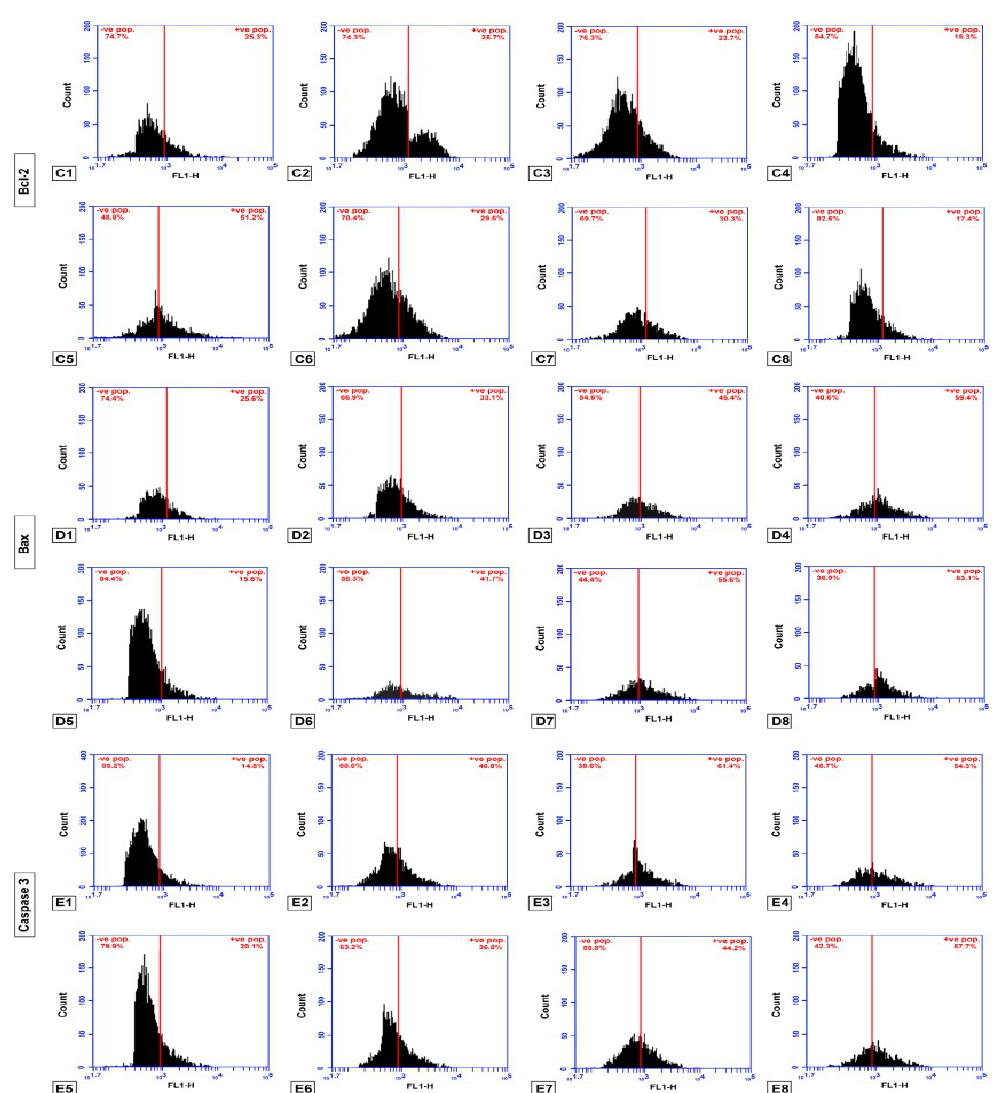
Figure 7. ( C ) Flow cytometry analysis of cell counts, detecting the number of Bcl-2 positive cells. ( D ) Flow cytometry analysis of cell counts, detecting the number of Bax positive cells. ( E ) Flow cytometry analysis of cell counts, detecting the number of Caspase 3 positive cells. 1: GMSCs control; 2: GMSCs treated with Schiff base complex; 3: GMSCs treated with cisplatin; 4: GMSCs treated with Schiff base complex and cisplatin together; 5: SCC cells; 6: SCC treated with Schiff base complex; 7: SCC treated with cisplatin; 8: SCC treated with Schiff base complex and cisplatin together. Table 5. Statistical analysis for Bax, Bcl2 and caspase-3 expression in GMSCs.